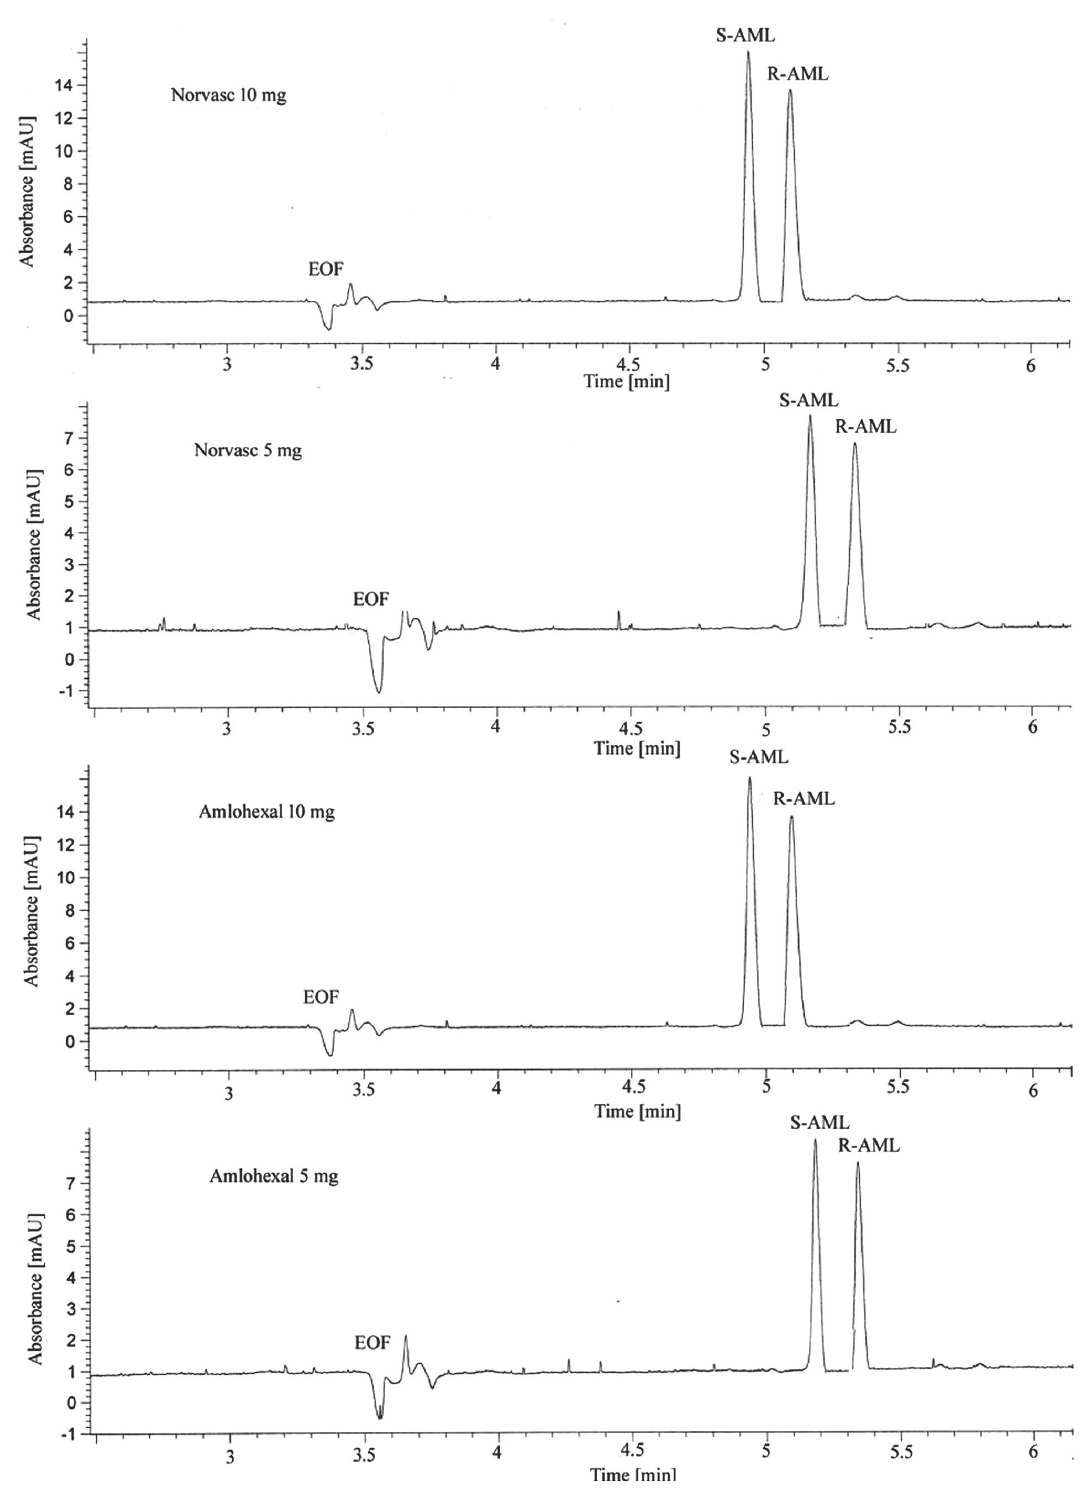
FIGURE 4 - Electropherograms from the enantioselective determination of AML in commercial pharmaceutical preparations (analytical conditions: 25 mM phosphate, pH 9.0, 15 mM CM-β-CD, +25 kV, 15 °C, 30 mbar/1 second, 230